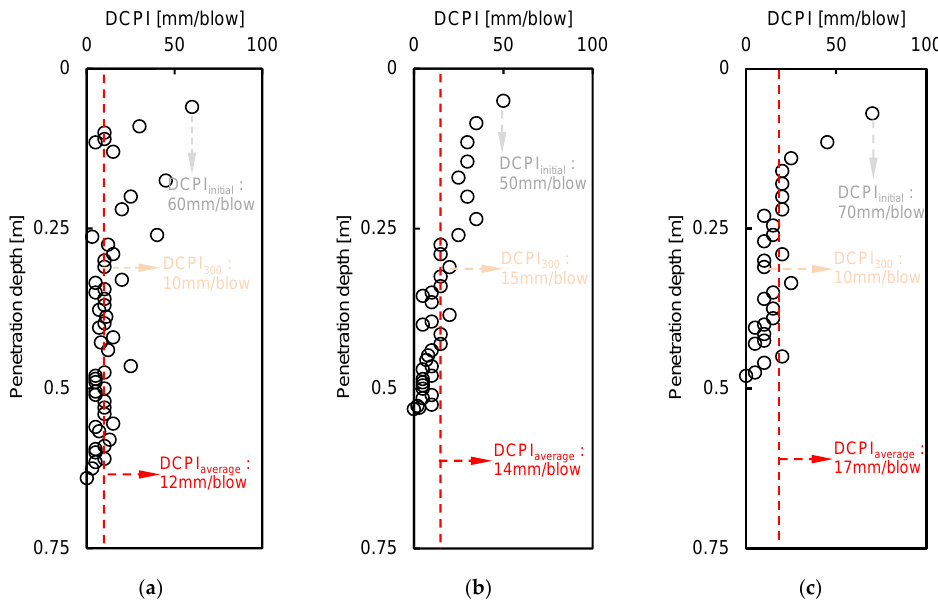
Figure 9. Results of dynamic cone penetrometer index (DCPI) through a dynamic cone penetrometer test (DCPT) at horizontal positions of ( a ) 80 m; ( b ) 120 m; ( c ) 160 m.